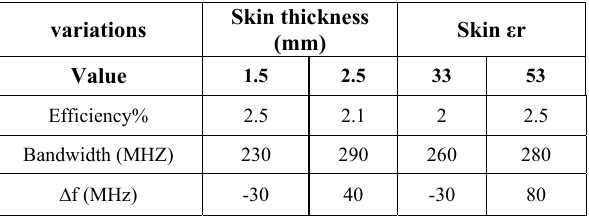
Table 2. Effects of variation of skin thickness and dielectric